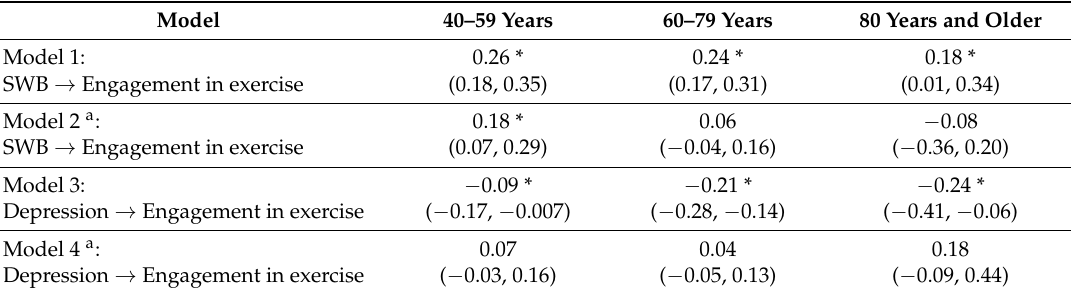
Table 6. Standardized Path Coefficients (and 99% Confidence Intervals) across Age.